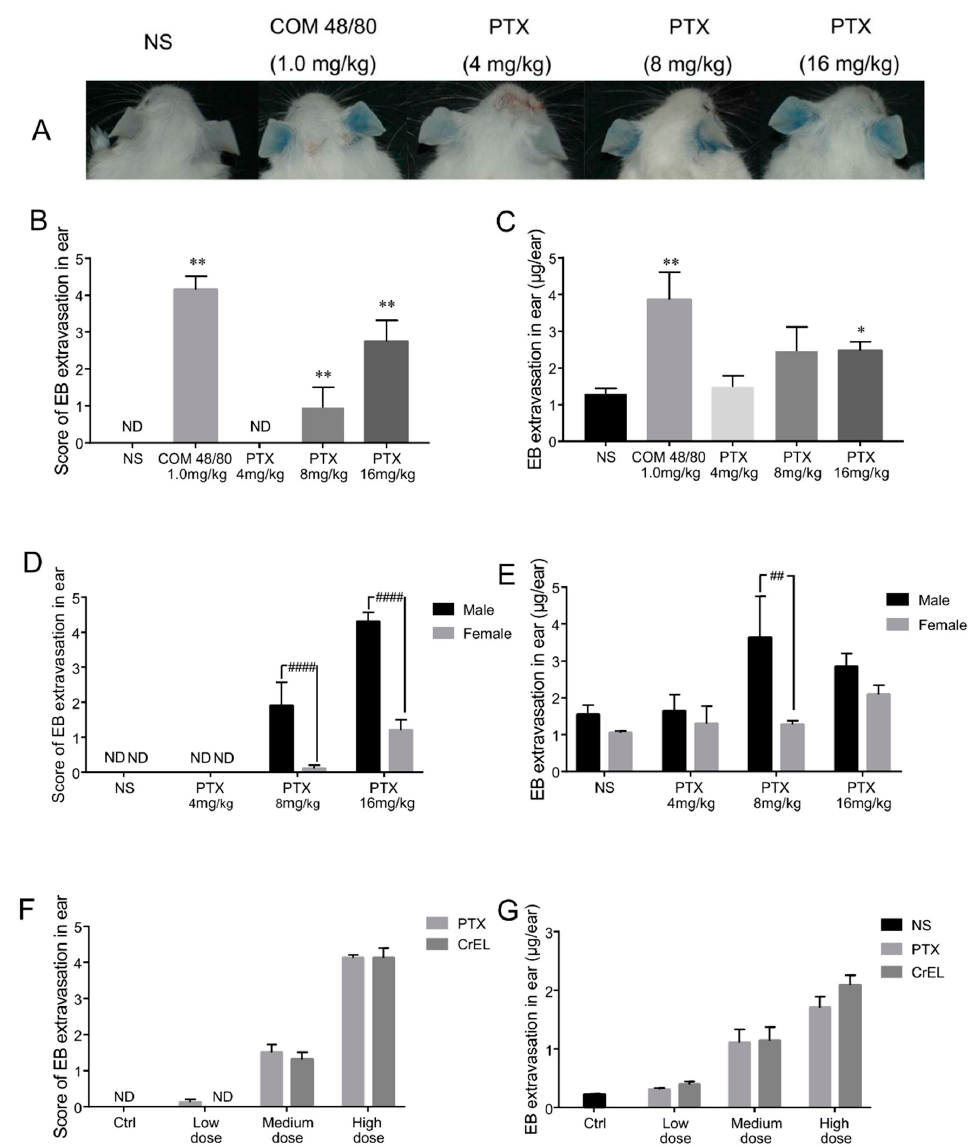
Figure 2. Paclitaxel injection induces vascular leakage in mice ears. ( A ) Blue color was observed in mice ears which received different treatments of normal saline (NS), compound 48/80 (COM 48/80) (1.0 mg/kg), or paclitaxel (PTX) injection (4, 8, or 16 mg/kg) plus Evans blue (EB). ( B , C ) The scores of blue colors and EB extravasation in mice ears with the administration of NS, COM 48/80, and 4, 8, or 16 mg/kg PTX injection (five male and five female mice per group). ( D , E ) Gender difference in scores and EB extravasation. ( F , G ) Vascular leakage of PTX injection and the excipient (CrEL) treatment ( n = 8 male mice per group). Low dose, 4 mg/kg PTX injection or 3.33% CrEL, medium dose, 8 mg/kg PTX injection or 6.67% CrEL, and high dose, 16 mg/kg PTX injection or 13.33% CrEL, respectively. ND, the main score was 0 in the group. * p < 0.05 and ** p < 0.01 compared with the NS-treated group. ## p < 0.01 and #### p < 0.0001, comparison between male and female mice.